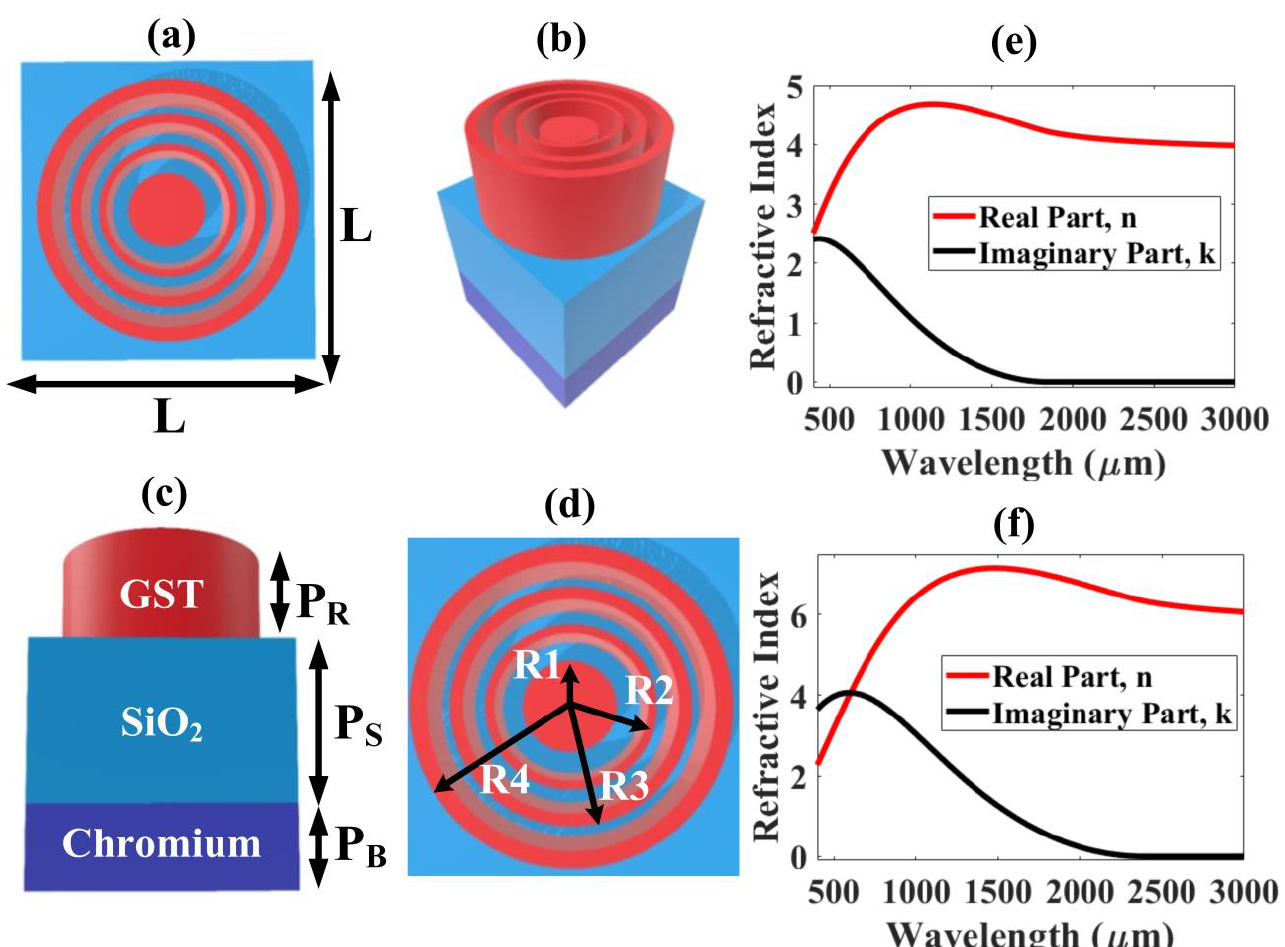
Figure 2. Structure of the concentric GST ring resonator-based solar absorber. ( a ) the top view for the ring resonator, ( b ) the 3D view for the solar absorber, ( c ) the front view for the solar absorber with the respective parameters, ( d ) top view with ring parameters, ( e ) real (n) and imaginary (k) parts of refractive index for aGST, ( f ) real (n) and imaginary (k) parts of refractive index for cGST.